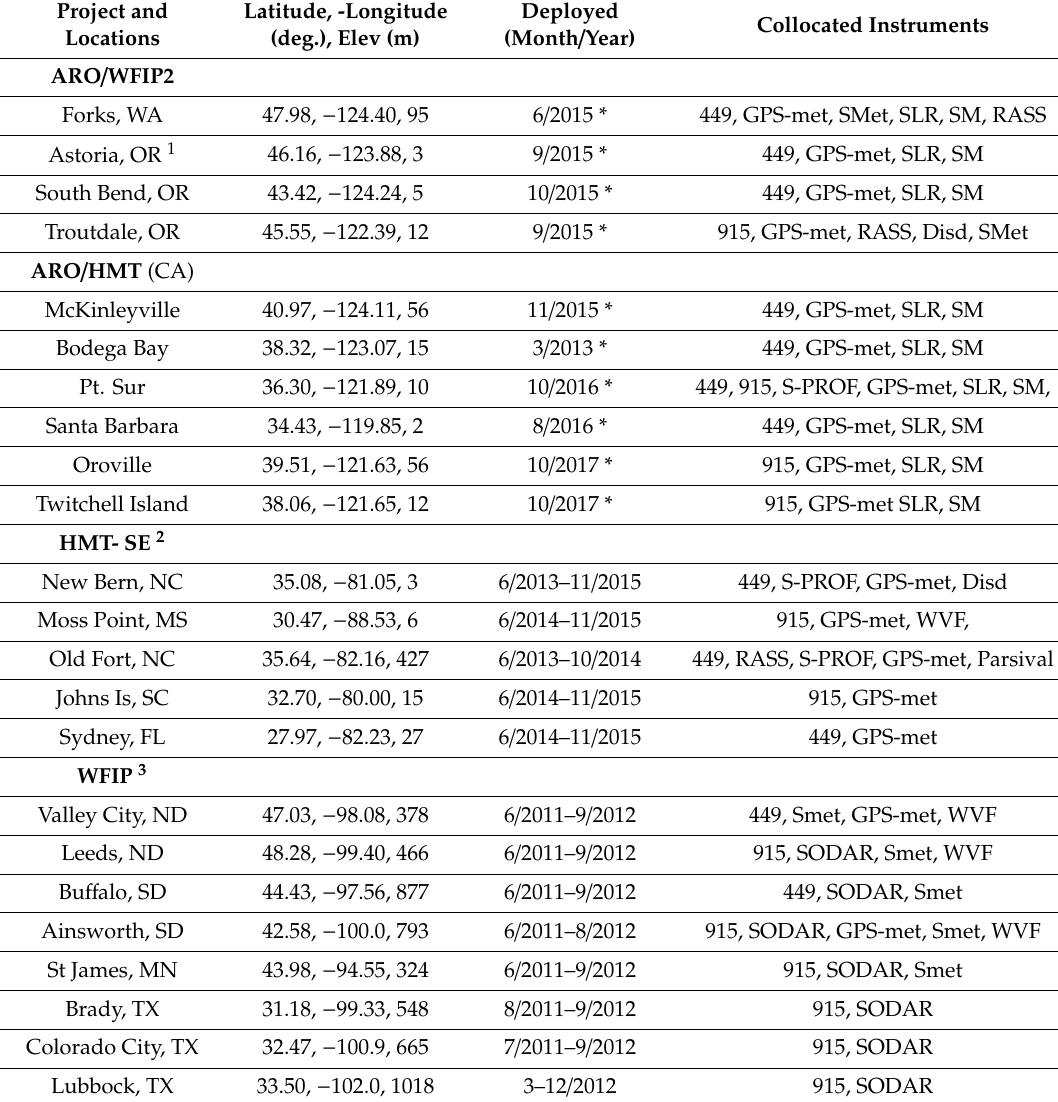
Table 2. Select WP radar stations. Stations shown are examples from over 200 ephemeral WP deployments, chosen because of their long records or deployment in areas with few observations. WPs are typically co-located with a suite of other instruments (right column). Abbreviations: 449